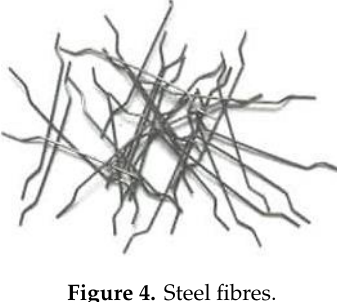
Figure 4. Steel fibres.